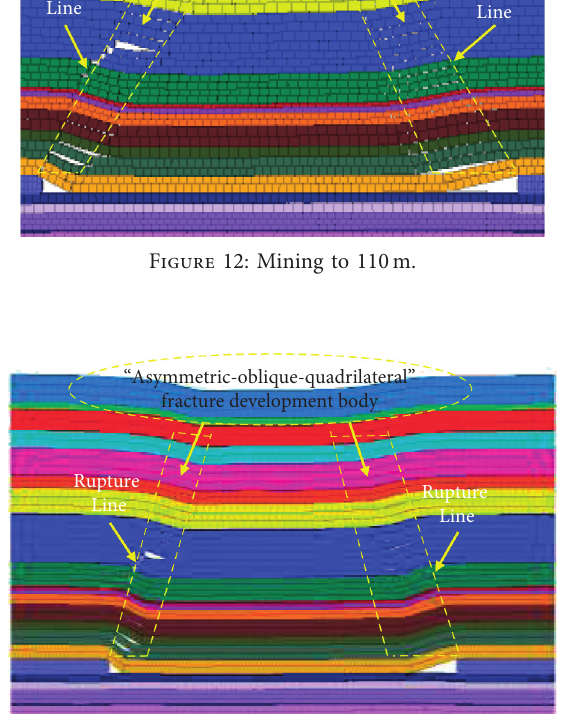
Figure 13: Mining to 180m.